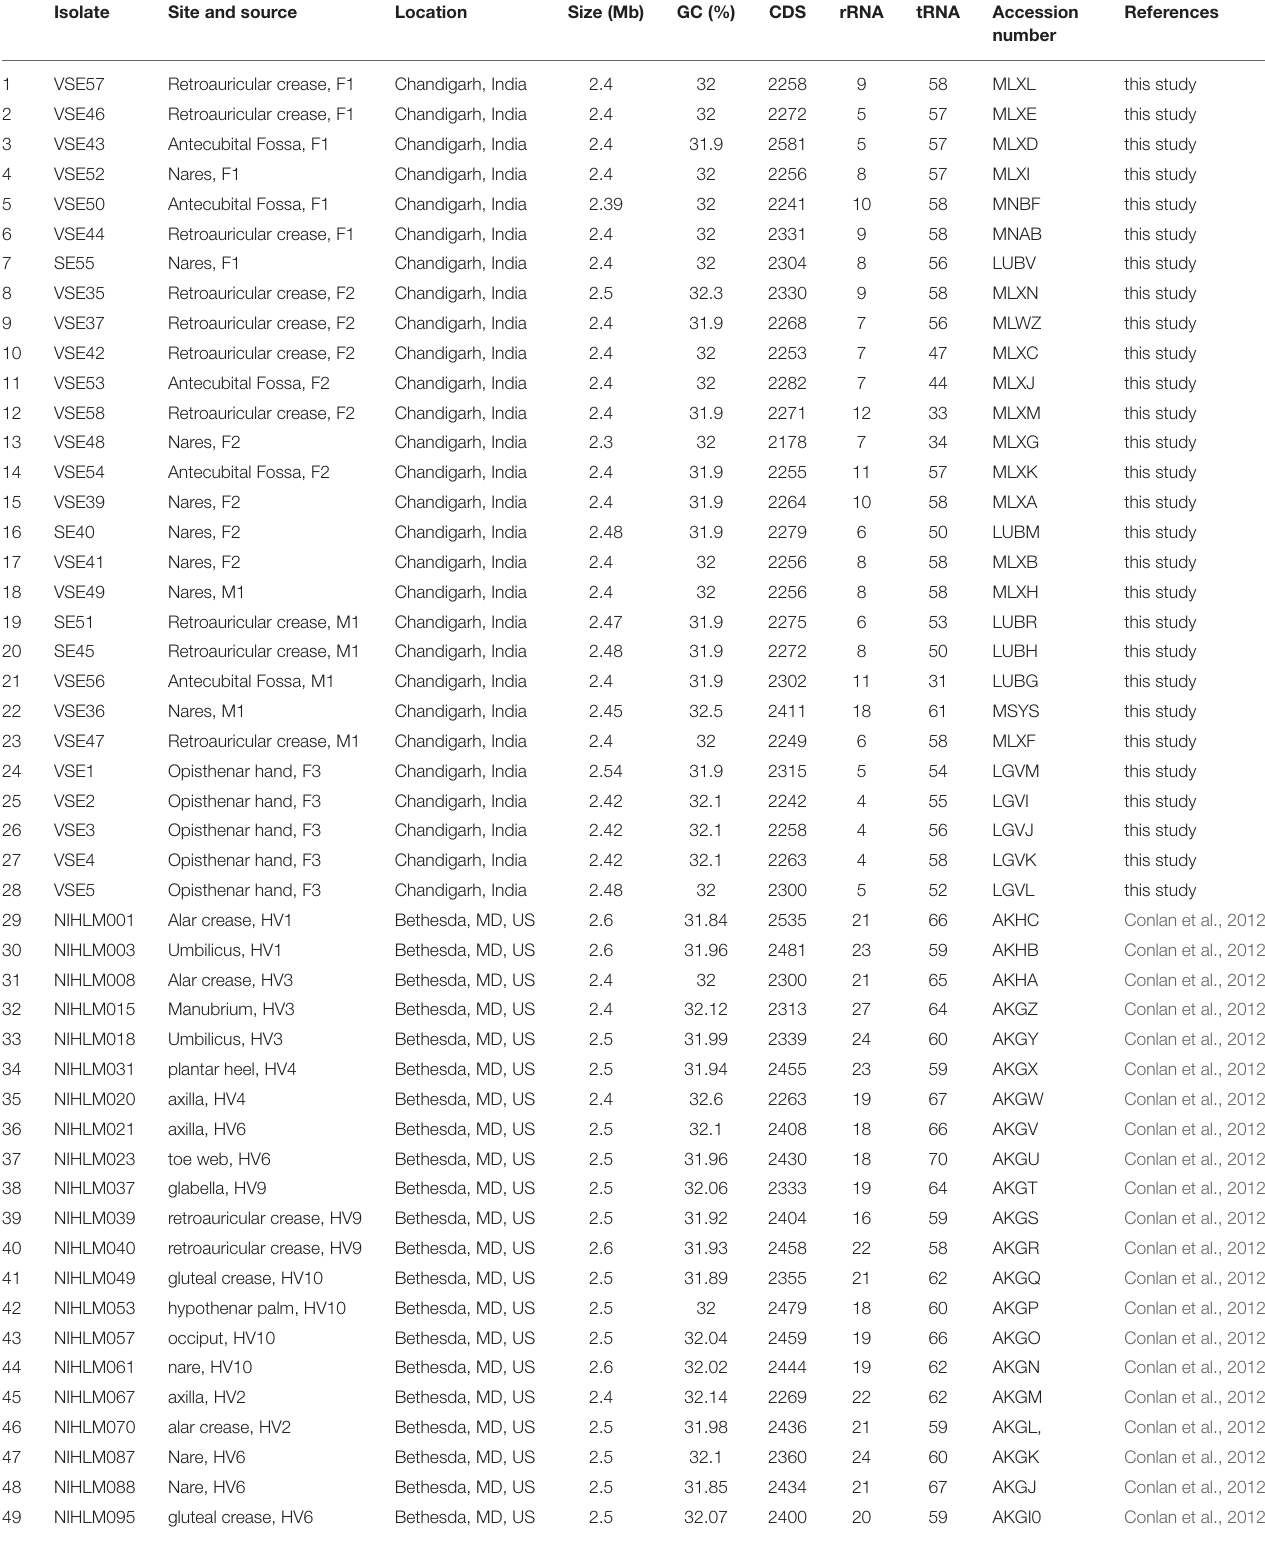
TABLE 1 | Details of the S. epidermidis isolates extracted from different body sites of healthy individuals, of two different geographical locations.